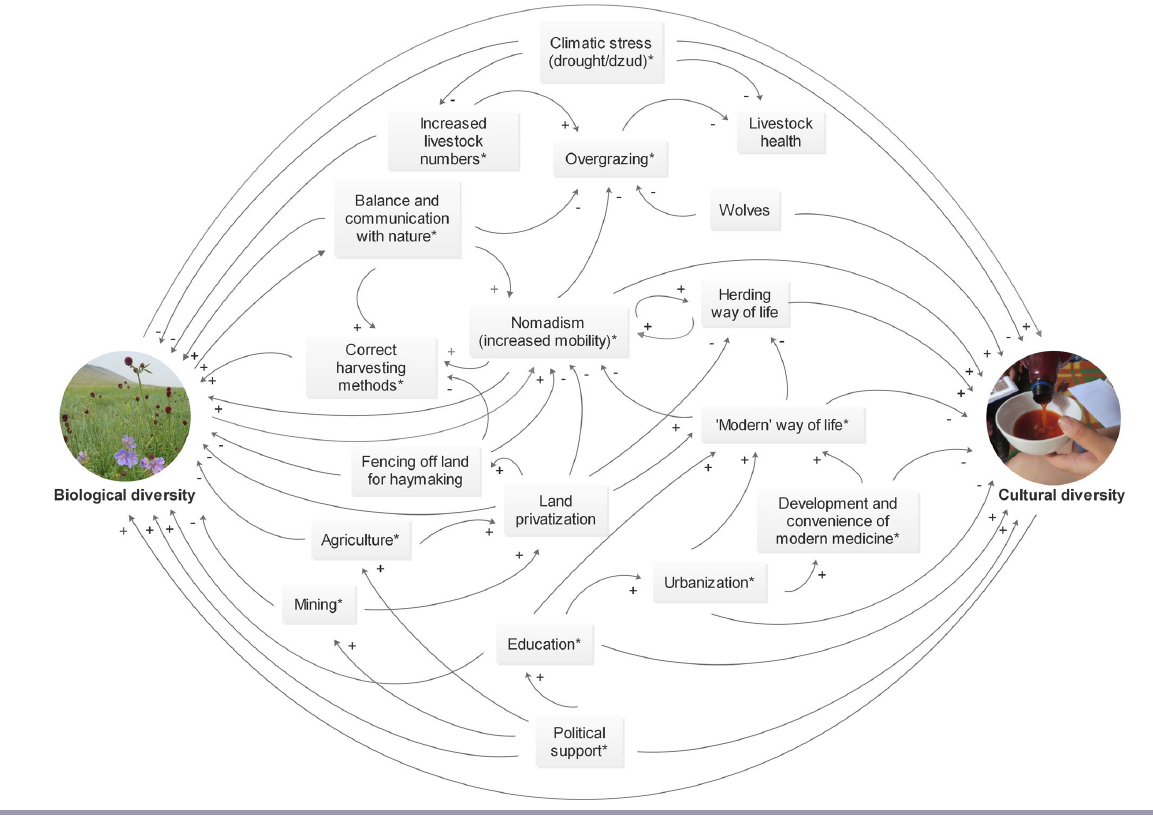
Fig. 4 . A systems diagram illustrating the links, relationships, and feedback loops between biological and cultural diversity in the Mongolian pastoralist context. Polarity signs on the arrow heads indicate whether the relationship leads to an increase (+) or a decrease (-) in the various elements. The * refers to concepts that were guided by the coding of interviews (see Table 3). Photo credit: B. Seele, H.